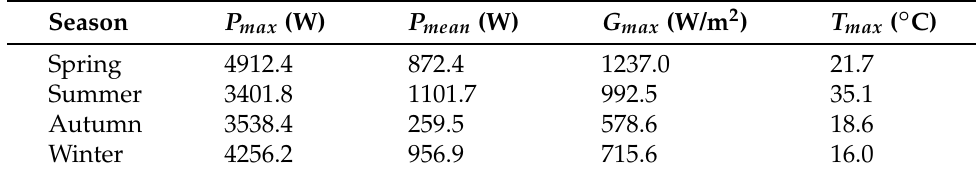
Table 1. PV plant data referred to seasonal periods shown from Figures 5–8.